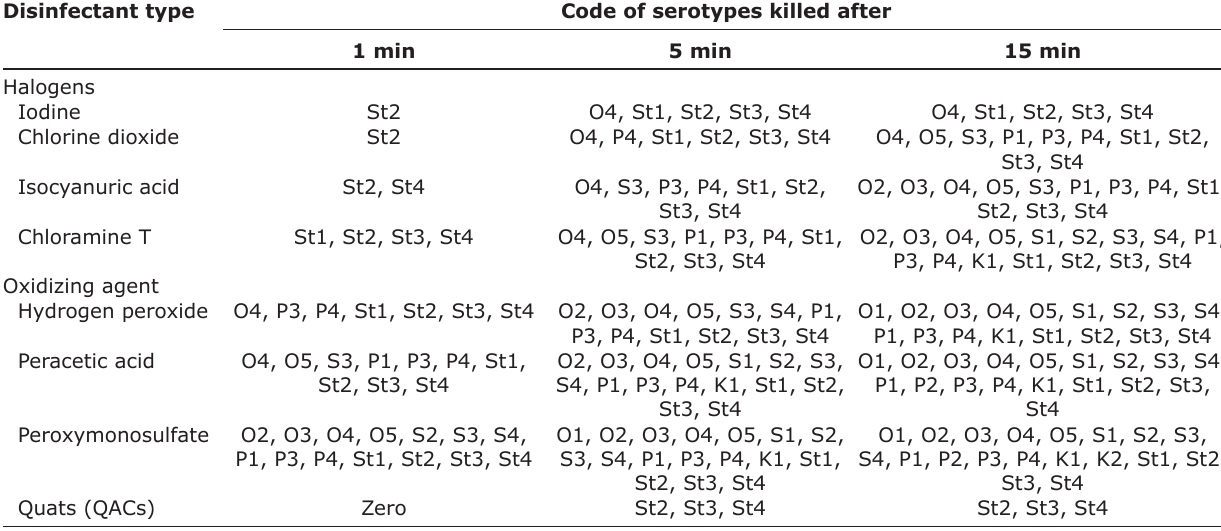
Table-6: Code of chlorine-resistant serotypes killed after 1 min, 5 min, and 15 min contact type with eight different disinfectants. Disinfectant type Code of serotypes killed after